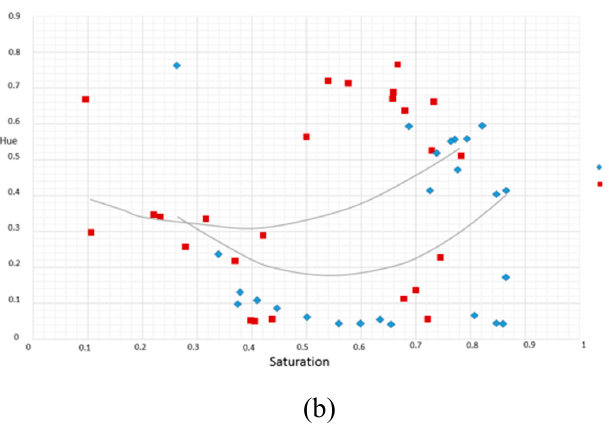
Figure 9. The relation between the saturation and the average hue of the authentic image (left) and the spoofed image (right) using nose (blue) and mouth (red) as examples. ( a ) real image; and ( b ) spoofed image.